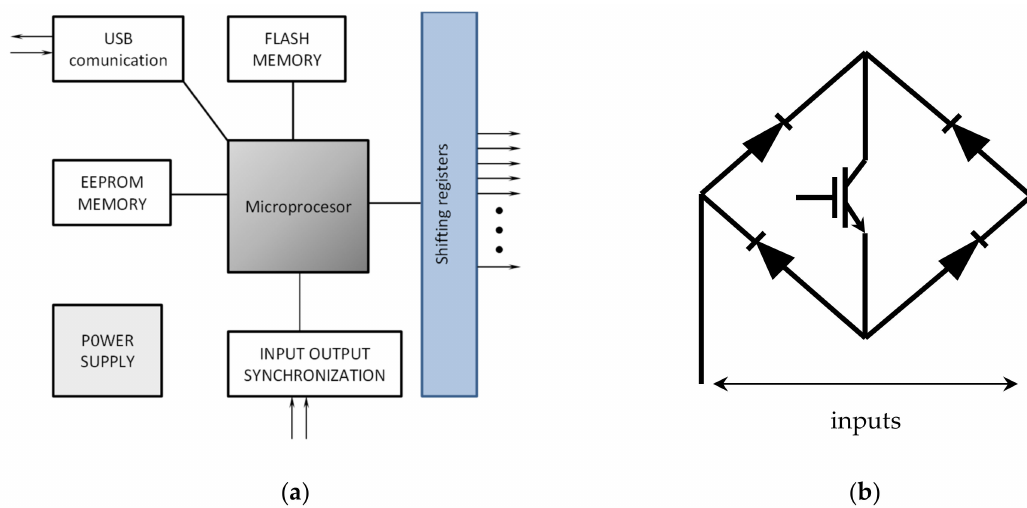
Figure 13. Elements of MMC structure: ( a ) The functional diagram of the real-life controller; ( b ) the structure of the applied switch.